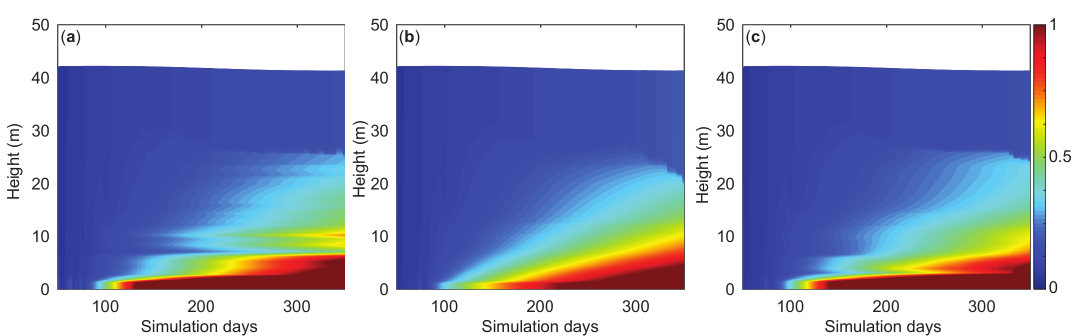
Figure 10. Example simulations for Lake Kinneret showing the hypolimnetic concentration of a passive tracer (normalized units) released from the sediment into the water layers at a constant rate for the case (a) without deep mixing, (b) with a constant vertical diffusivity, D z = 2 × 10 − 6 m 2 s − 1 , and (c) with the depth-dependent vertical diffusivity formulation (Eq. 57). The thermal structure for this case is in Fig.